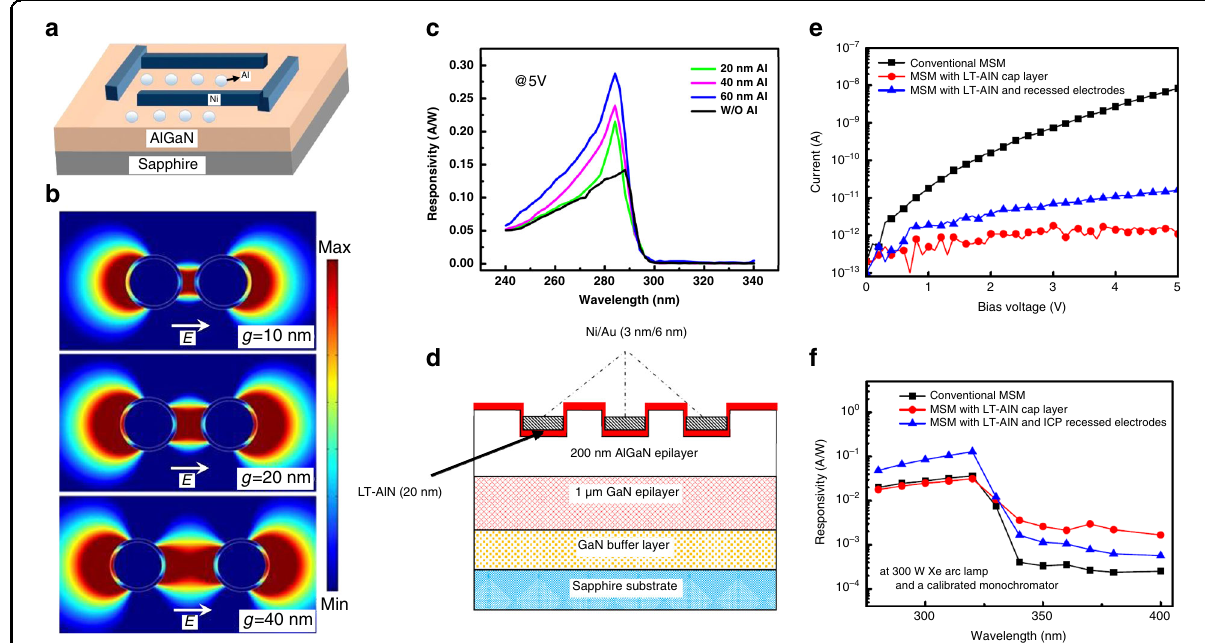
Fig. 12 Performance improvement methods on AlGaN MSM photodetectors. a Schematic structure of AlGaN MSM photodetector with Al nanoparticles. b Electric fi eld distribution of Al nanoparticles with changing gaps. c Responsivity of devices with and without Al nanoparticles. Reprinted with permission from Li et al. 187 . Copyright 2014 Optical Society of America. d Schematic structure of AlGaN with low-temperature AlN cap layer and recessed electrodes. e Dark current curves of the three samples. f Spectral response of the three samples. Reprinted with permission from Chen et al. 188 . Copyright 2010 The Japan Society of Applied